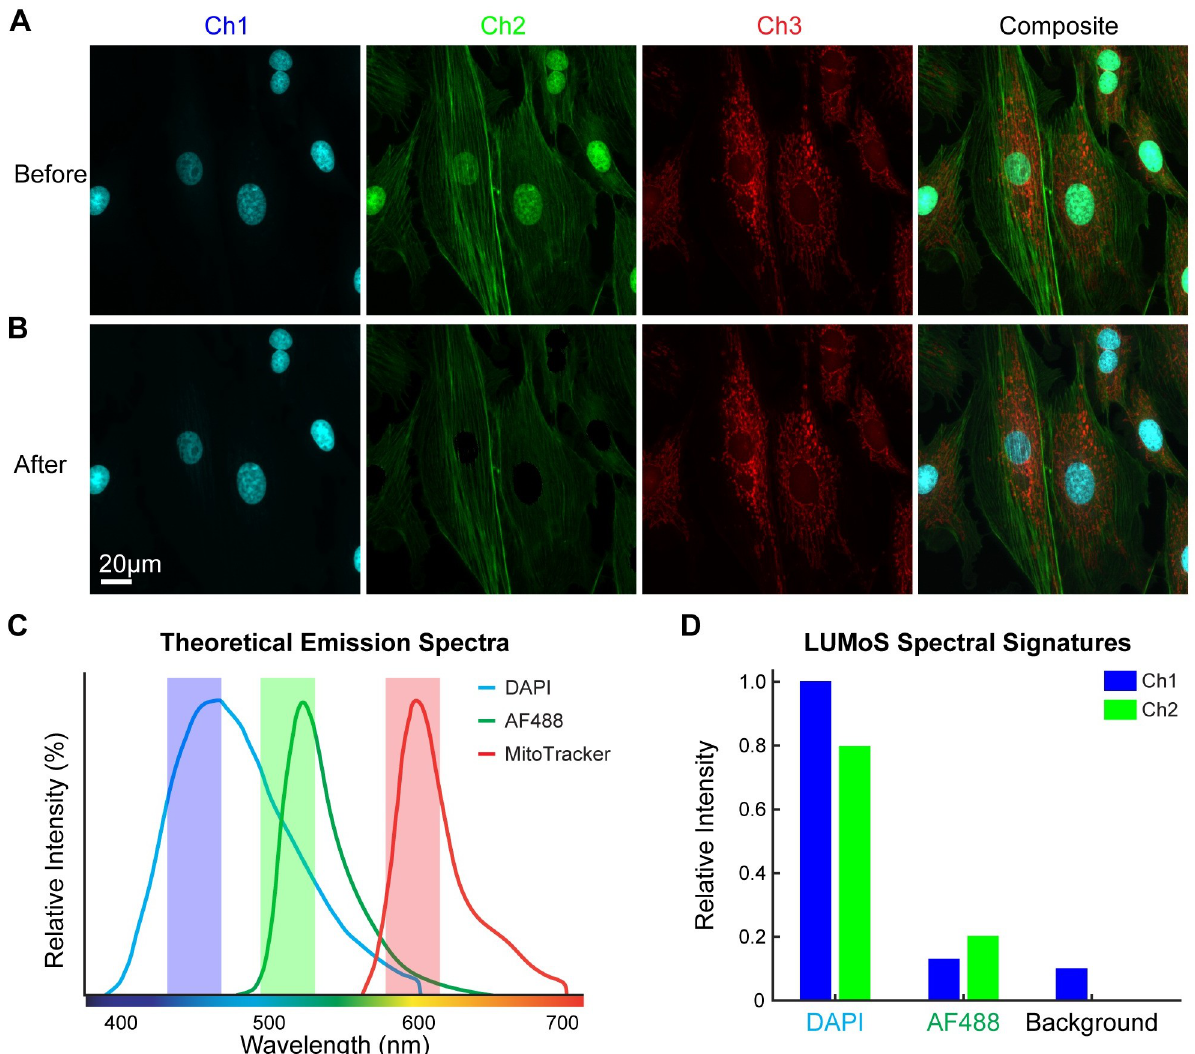
Fig 3. LUMoS unmixing of BPAE cells with channels bleed-through. (A) BPAE cell stained with DAPI in nuclei, AF488 in actin, and MitoTracker Red in mitochondria, and imaged with 2PLSM. Images shown were 2D maximum intensity projections of 3D z-stacks. The green channel (Ch2) had a mix of actin and nuclei with the DAPI signals bleeding into the AF488. (B) LUMoS unmixing results of the mixed images in A. Only Ch1 and Ch2 images were used for separation. Note the clear separation of the nuclei from the green channel after unmixing. Background pixels were removed. (C) The theoretical emission spectra of DAPI, AF488 and MitoTracker Red. The filter bandwidths were plotted as shaded areas. Note the long tail of the DAPI spectrum blending into the green channel. (D) The relative intensities of the LUMoS unmixed DAPI and AF488 pixel clusters detected by the green and blue channels. Background was separated as an additional cluster with relatively low intensity in both